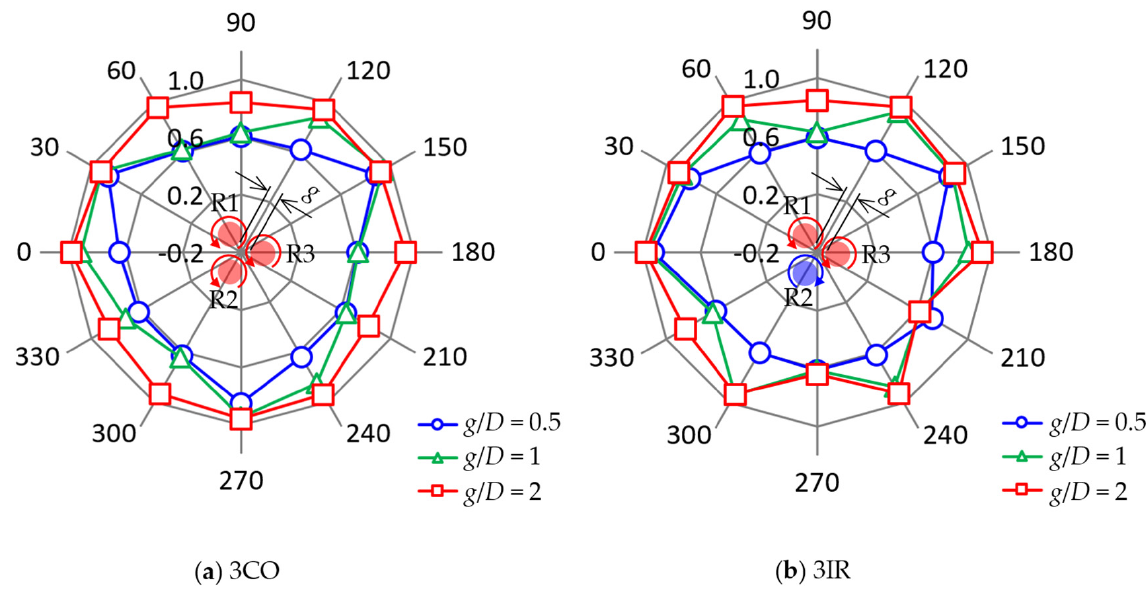
Figure 18. Experimental results of the gap dependence of the 12 ‐ wind ‐ direction for the average normalized rotational speed in a trio of VAWT models at V = 12 m/s in: ( a ) 3CO configuration; ( b ) 3IR configuration.